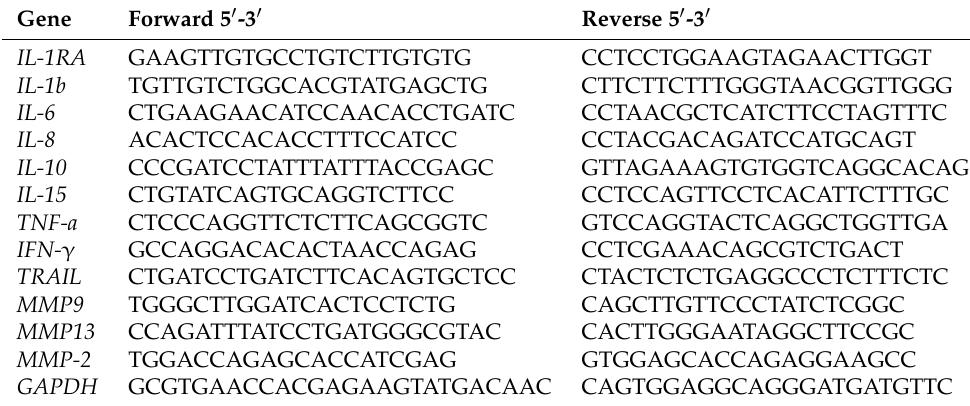
Table 3. Oligonucleotide Sequences for